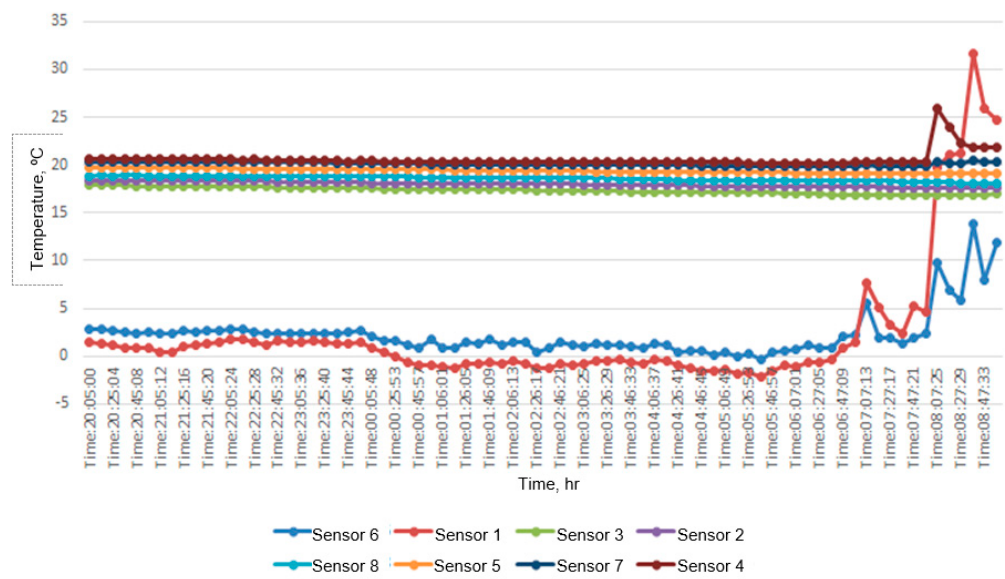
Figure 5. Change in sensor data for a typical measurement day.